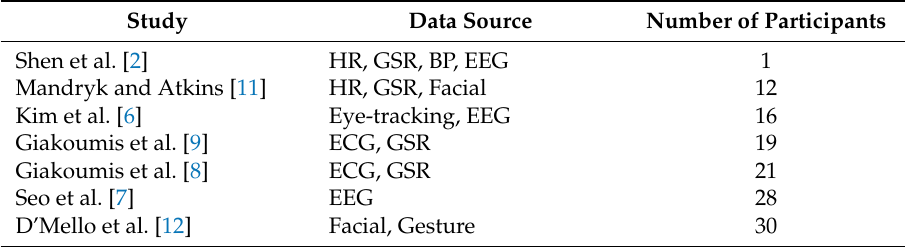
Table 1. Studies on boredom classification using physiological